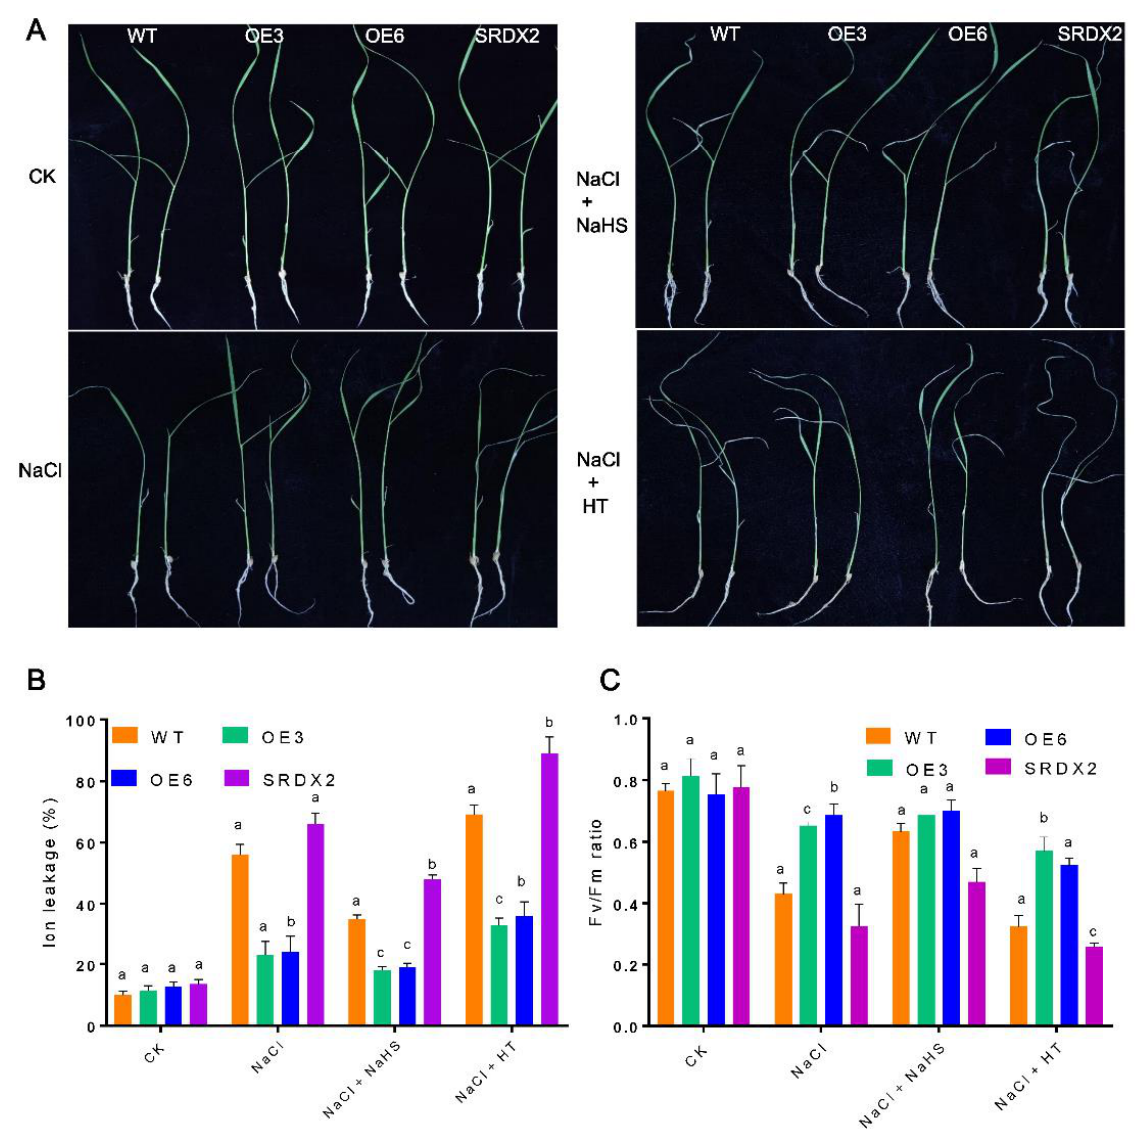
Figure 10. Effects of NaHS and hypotaurine (HT) on salt tolerance in WT and transgenic lines. The 14-day-old seedlings were pretreated with or without NaHS (100 µ M) and HT (2 mM) for 6 h, and then shifted to a 1/2 Murashige and Skoog (MS) solution with or without NaCl (200 mM) for another 48 h. ( A ) Phenotypes: ion leakage ( B ) and Fv/Fm ( C ) were measured. Seedlings without chemical treatment were regarded as the control check (CK). Values are means ± SE of three independent experiments with at least three replicates for each. Three independent experiments were conducted, showing similar results. Statistical analyses were performed by a two-way ANOVA, followed by a Tukey’s multiple comparison test. Different letters indicate significant differences at p <